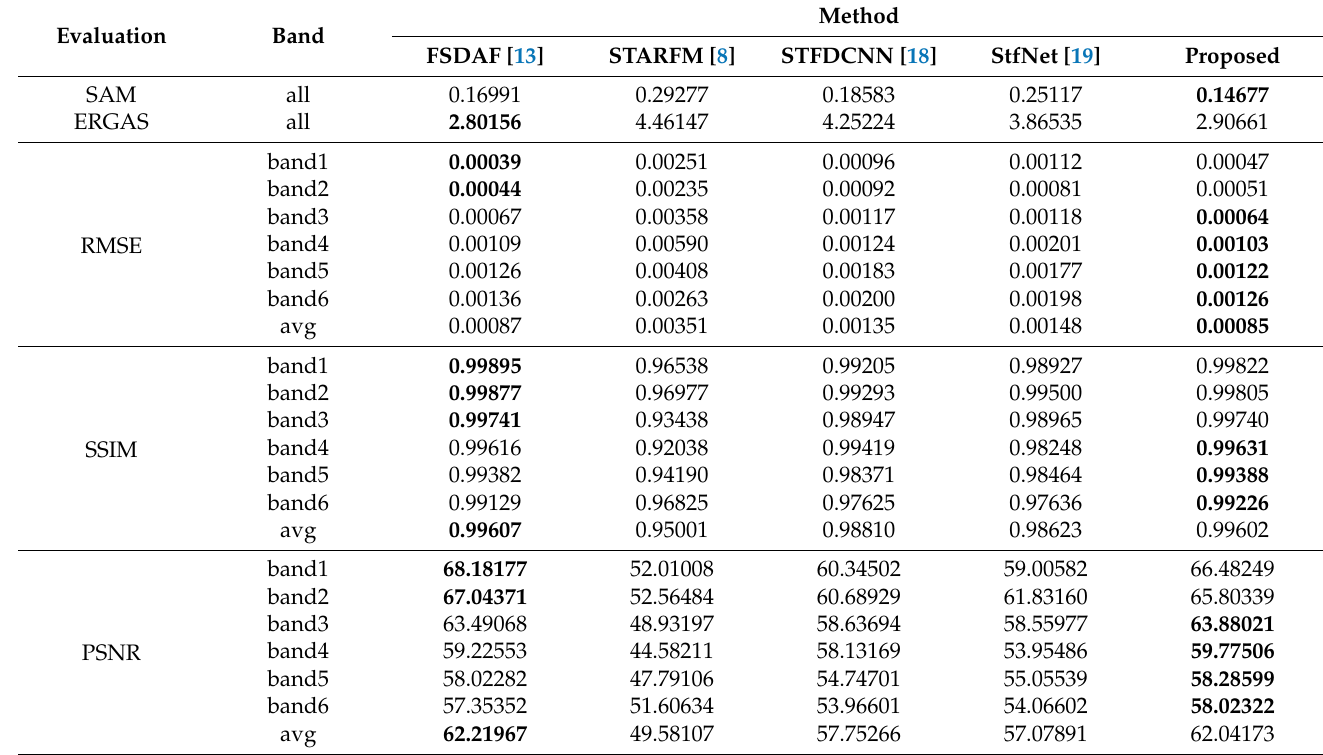
Table 4. Quantitative assessment of different spatiotemporal fusion methods for the AHB [32,33]